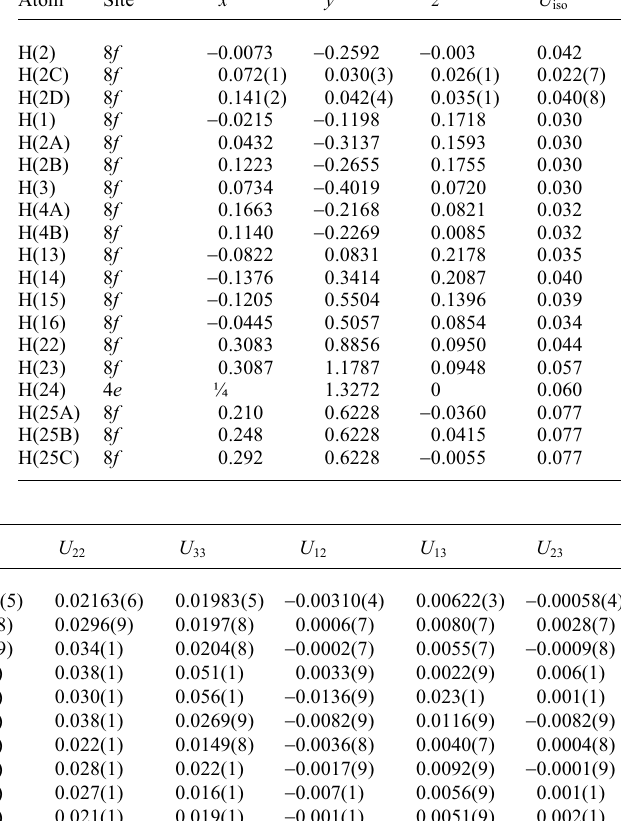
Table 2. Atomic coordinates and displacement parameters (in Å 2 ) .